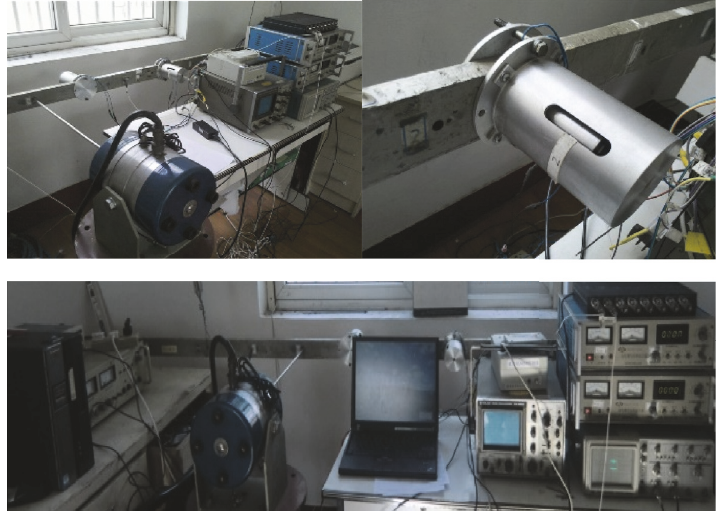
Figure 14: The diagram of experimental set-up.